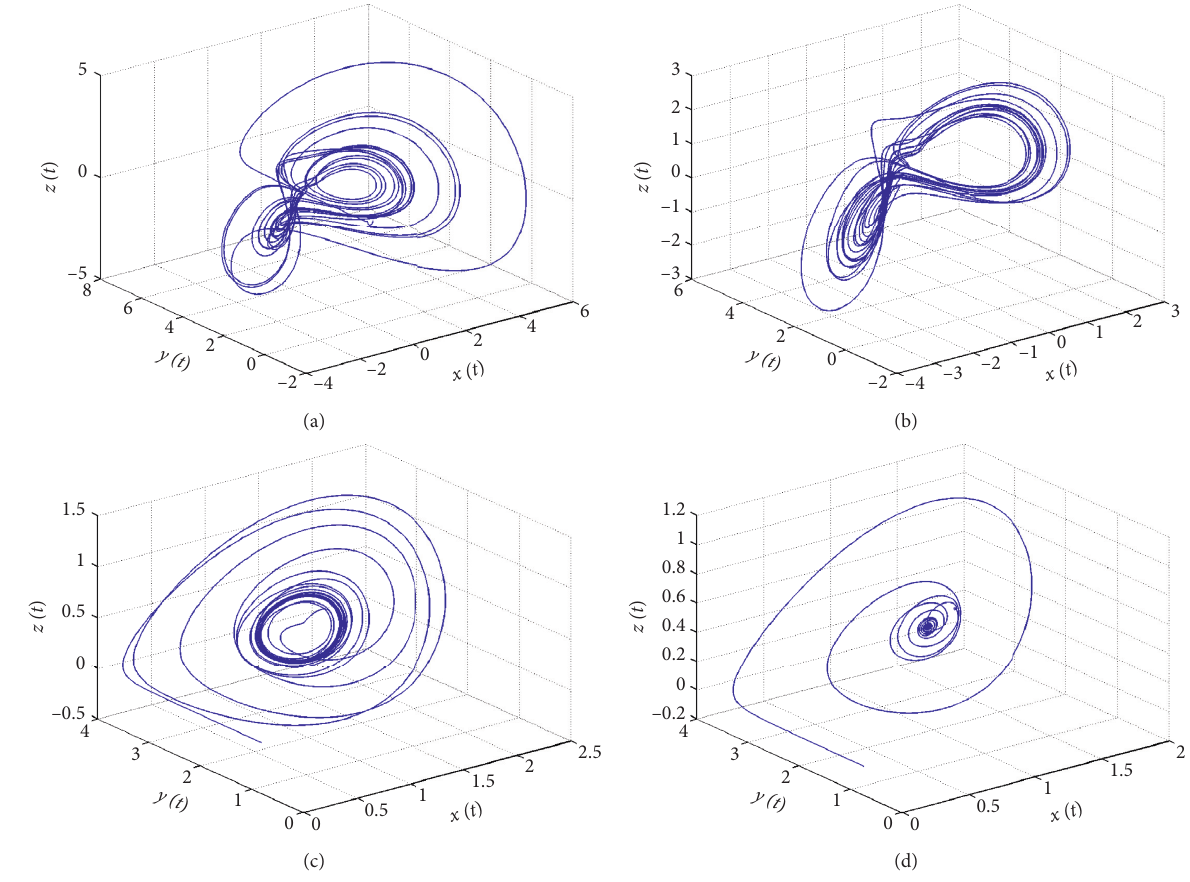
Figure 5: 3D plots of FOS model (37) with a � 0 . 4 , b � 0 . 175 , c � 0 . 4, and τ � 0 . 2, showing that (a) chaos exists at α � 1; (b) chaos exists at α � 0 . 99; (c) quasi-periodic attractor exists at α � 0 . 95; (d) asymptotic attractor exists at α � 0 . 90.